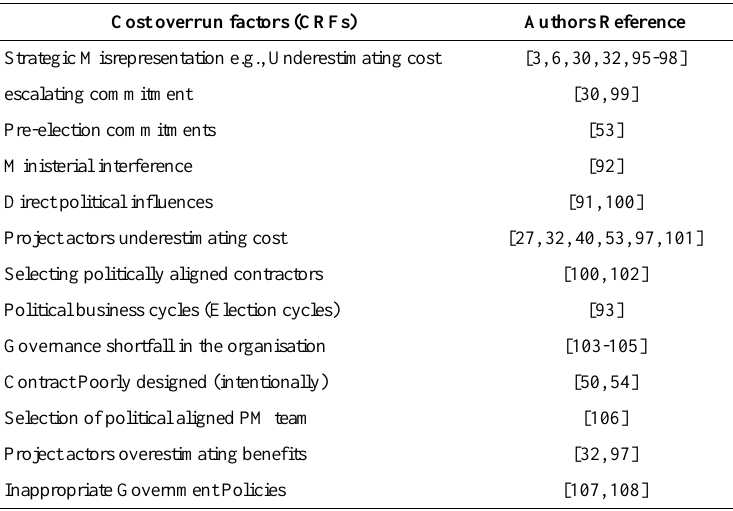
Table 2. Critical Risk Group (Root Cause) -